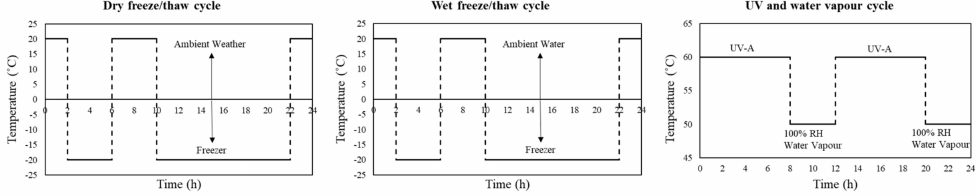
Figure 2. Environmental condition cycles used in this study.